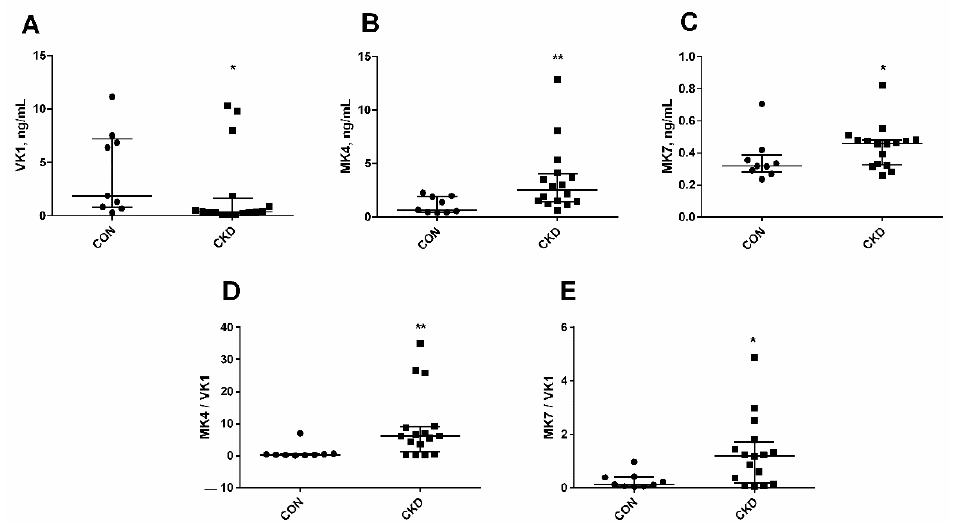
Figure 1. Vitamin K1 ( A ), MK4 ( B ), MK7 ( C ) concentrations, and the ratios of MK4/VK1 ( D ) and MK7/VK1 ( E ) in serum rats with chronic kidney disease (CKD) and healthy controls (CON) fed with a standard rodent diet. The lines correspond to the 25th and 75th percentiles and the median. * p < 0.05, ** p < 0.01 CON versus CKD rats; VK1—phylloquinone; MK4—Menaquinone 4; MK7—Menaquinone 7; the circles represent results in controls; the squares represent results in CKD